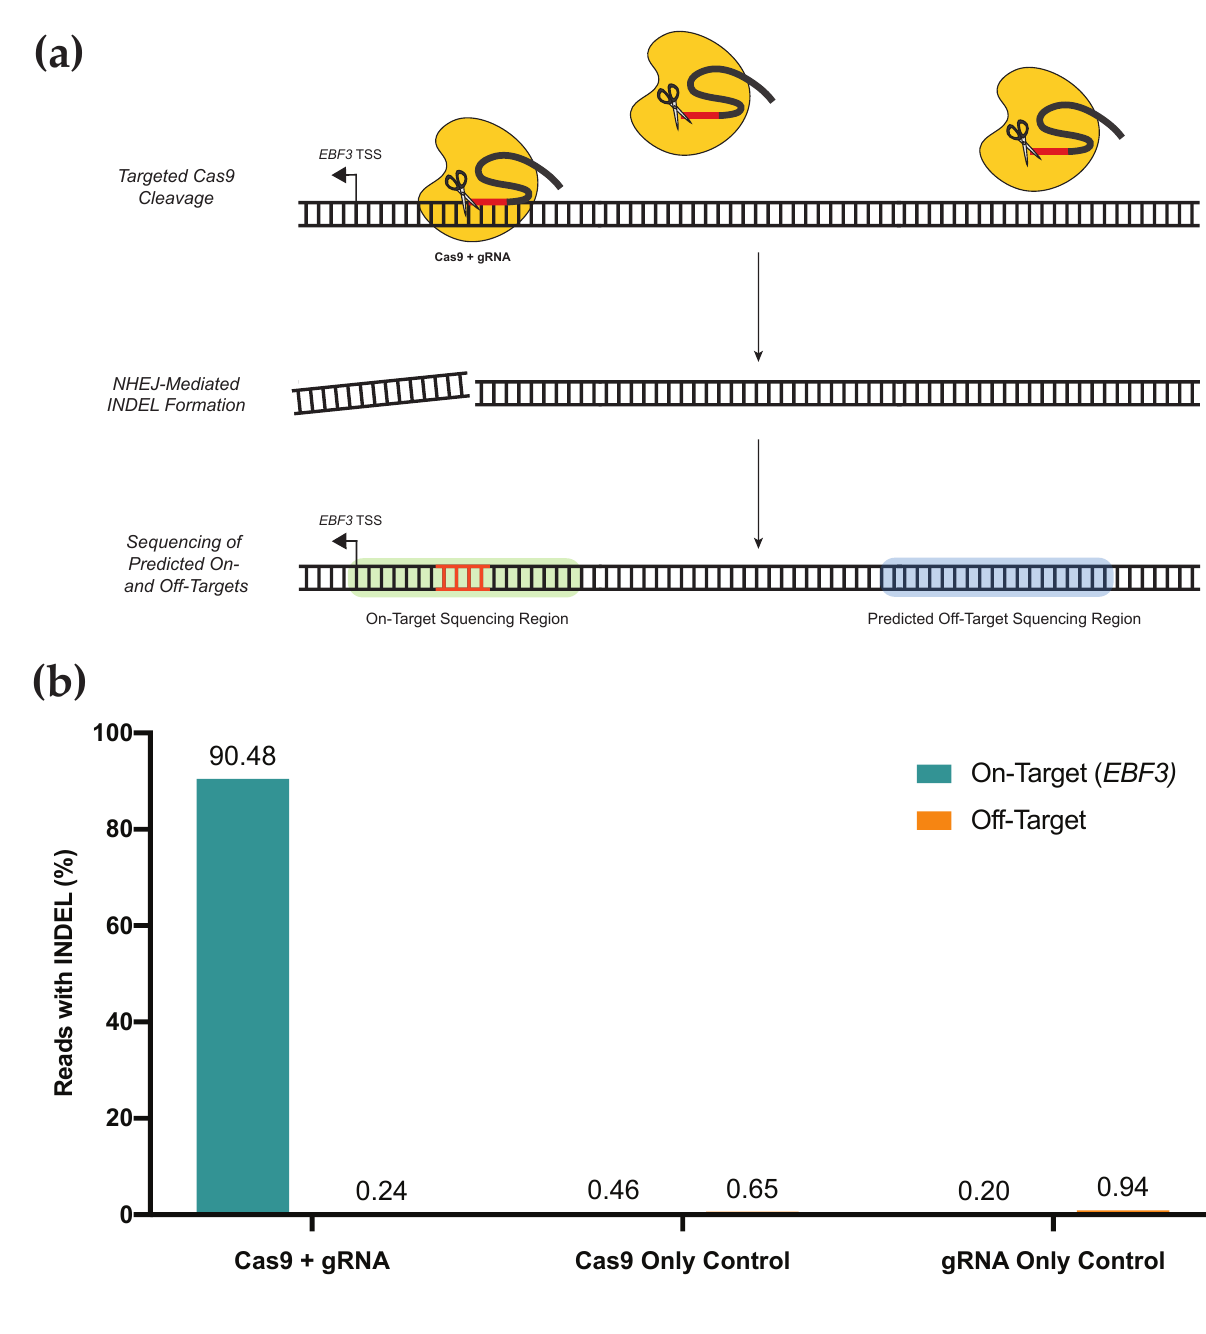
Figure 5. ( a ) Rapid screening method for on- and off-target assessment of unique gRNA constructs. The gRNA of interest and active Cas9 construct are transfected into cell lines. Directed by the gRNA, Cas9 binds to genomic loci and induces double-stranded cleavage of the DNA molecule, which is subsequently repaired via non-homologous end joining (NHEJ). NHEJ introduces insertions or deletions (INDELs; orange) at the repaired locus, which can be detected via sequencing, providing a surrogate for gRNA + Cas9 activity at any given locus. Then, the on-target locus and top ten off-target loci are sequenced via targeted high-throughput sequencing. ( b ) Assessment of on- and off-target activity for the gRNA used to successfully edit EBF3 promoter methylation. Percentage of sequenced reads containing INDELs provides the surrogate measure of activity at each locus; data from off-target loci are combined as shown. Our gRNA shows the very high on-target efficacy of INDEL generation and minimal off-target impacts for the top ten predicted off-target loci. Cas9-only and gRNA-only controls display minimal on- or off-target